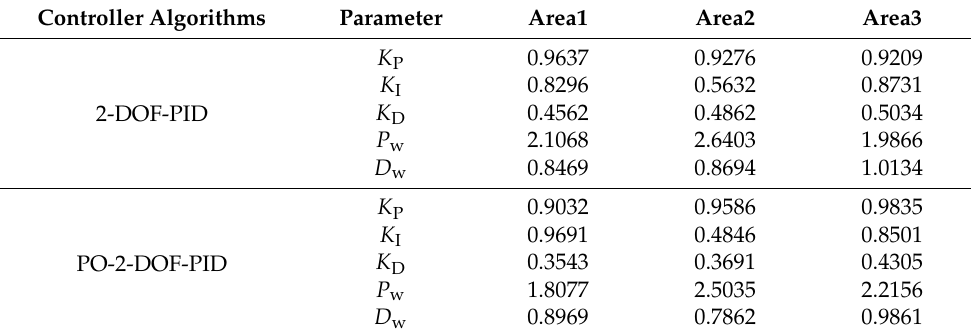
Table 3. The parameters of the